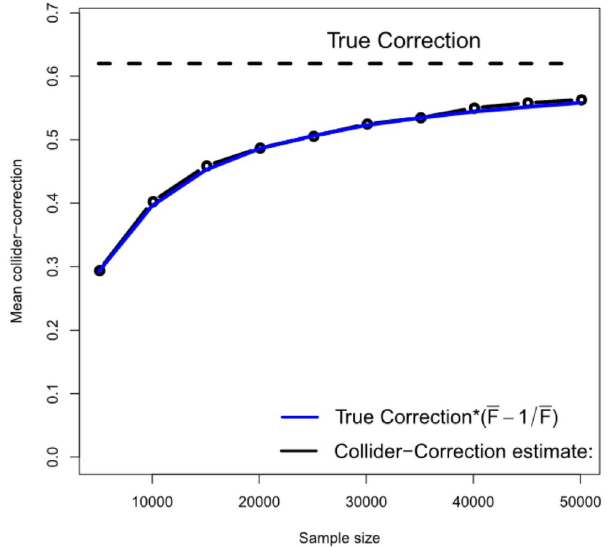
Fig 5. An illustration that the Collider-Correction slope’s dilution can be accurately predicted using the F-